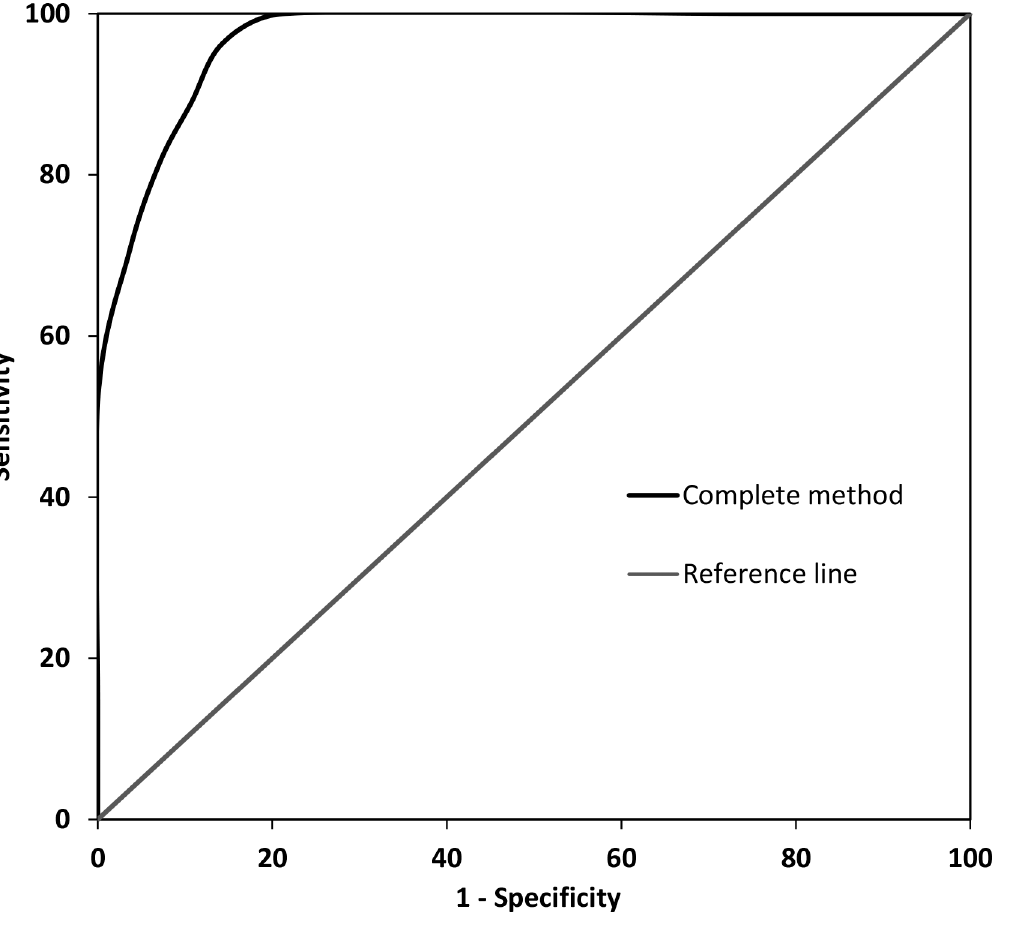
Fig 2. ROC curve of the predictor variable of the complete method.